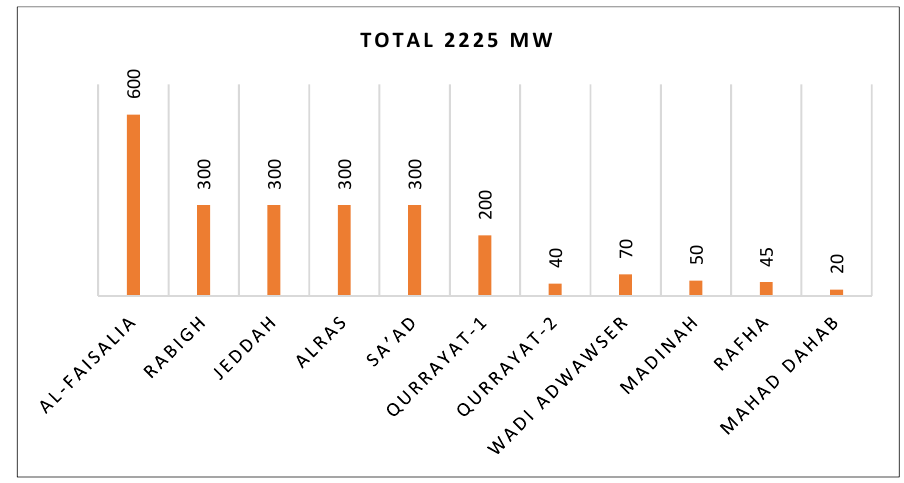
Figure 2. List of 11 solar photovoltaic project tenders in 2019.